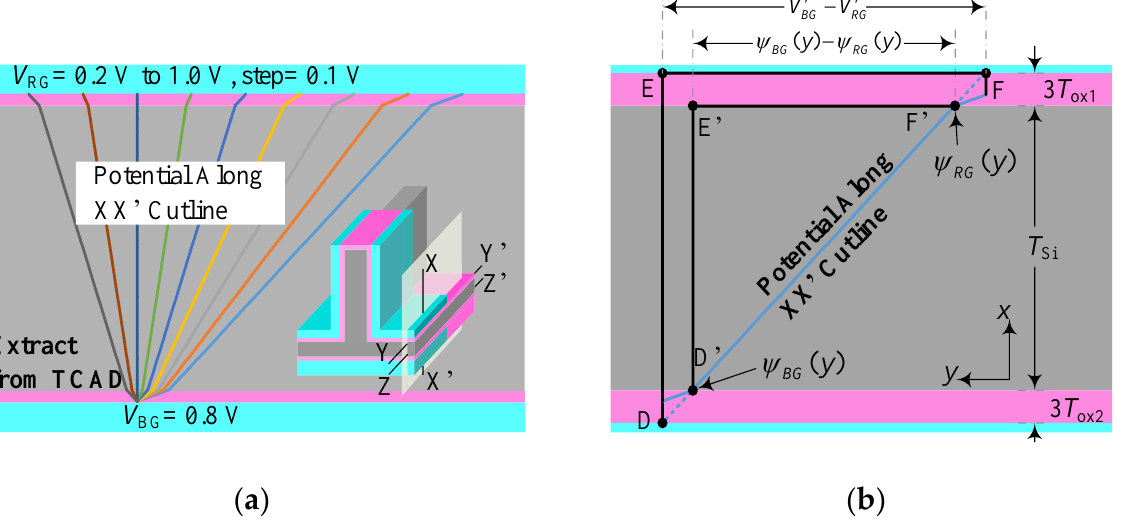
Figure 3. ( a ) Potential distribution (extracted by TCAD) along the XX’ cutline for increasing V RG from 0.2 V to 1.0 V in steps of 0.1 V, where V BG is fixed at 0.8 V. ( b ) Simplified model of the potential along the XX’ cutline. All cutlines lie in the YZ plane, and the YY’ and ZZ’ cutlines indicate the surface potential near the right and bottom gates, respectively.